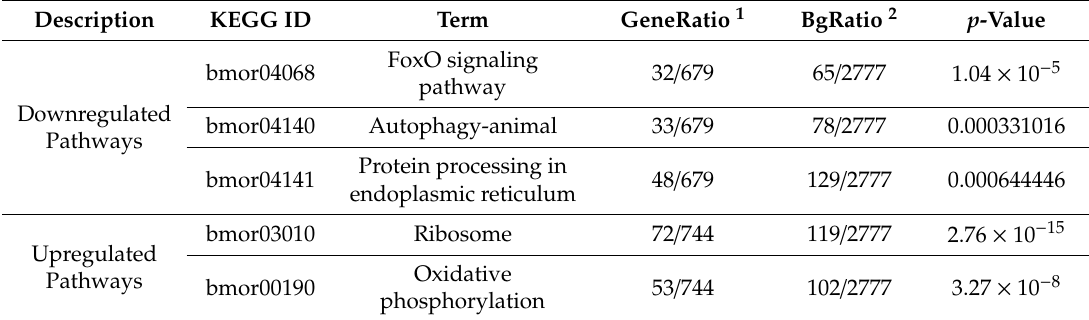
Figure 4. Kyoto Encyclopedia of Genes and Genomes enrichment scatter plot of di ff erentially expressed genes (DEGs) in silkworm diapause eggs at 48 h versus that at 20 h after oviposition. Y -axis represents name of pathway, and x -axis represents rich factor. Dot size represents number of di ff erent genes, and color indicates adjusted p -value. ( A ) Downregulated DEG enrichment analysis results. ( B ) Upregulated DEG enrichment analysis results. Table 2. Kyoto Encyclopedia of Genes and Genomes (KEGG) pathway significant enrichment of di ff erentially expressed genes in silkworm diapause eggs at 48 h versus that at 20 h after oviposition. FoxO, Forkhead box protein